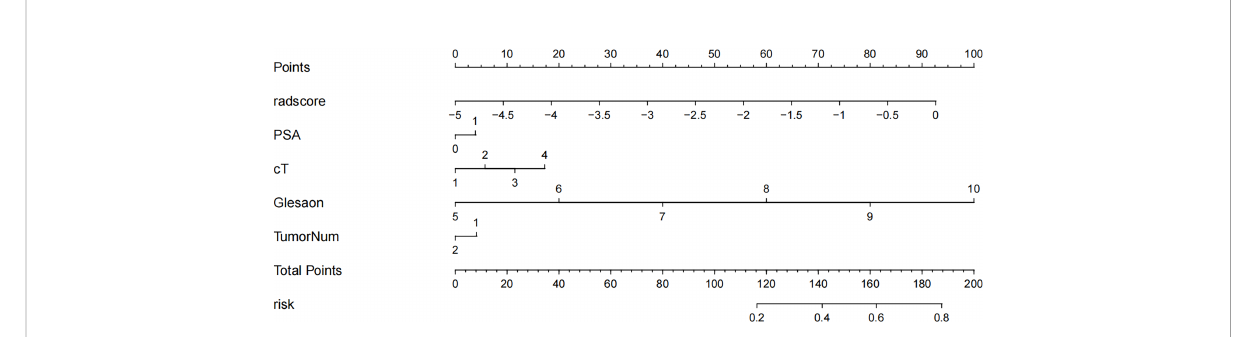
FIGURE 5 Radiology nomogram. The radiology nomogram prediction model predicts the probability of progression in patients with PCa. How to use: (1) locate the patient ’ s radiomic score, PSA level, clinical T-stage, Gleason score, number of tumor and then draw a straight line on the top dot axis to obtain the corresponding score; (2) sum the scores obtained (3) fi nd the fi nal sum on the total point axis and draw a straight line down to assess the risk of progression in patients with prostate